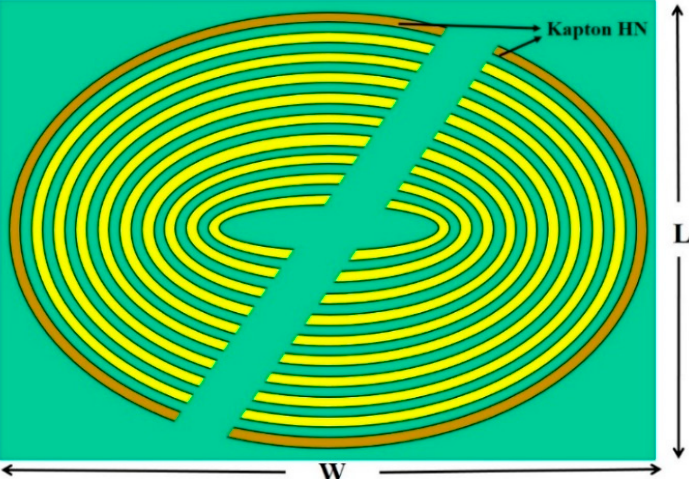
Figure 15. Proposed moisture sensor tag layout.